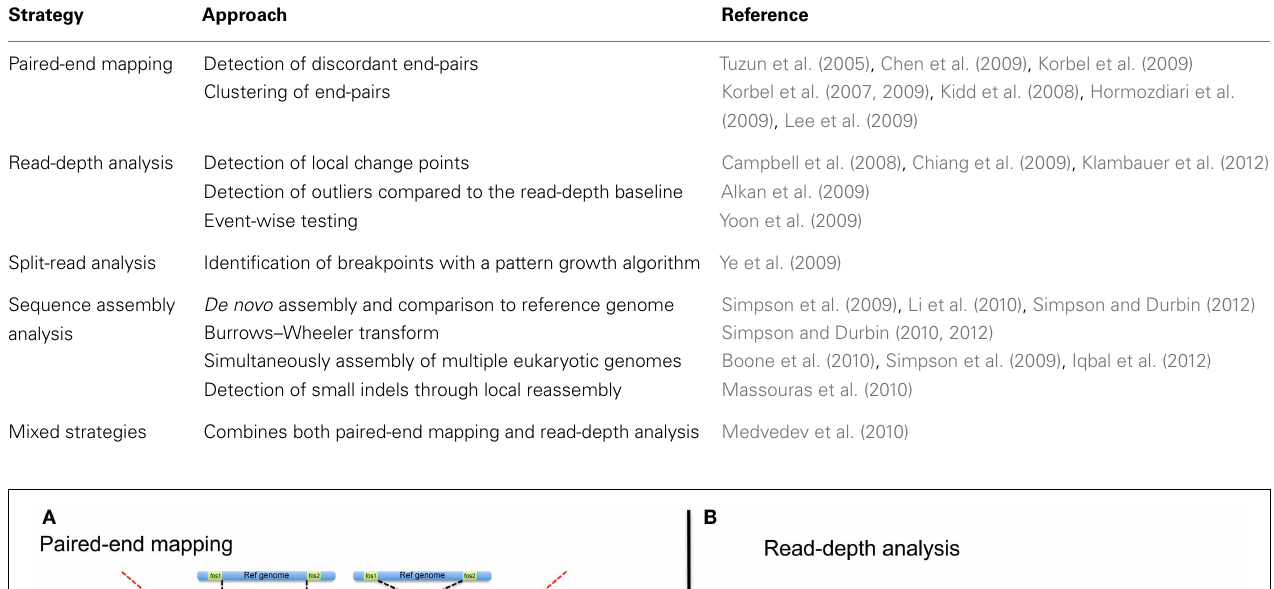
Table 2 |Algorithms for the detection of structural variants from NGS data.